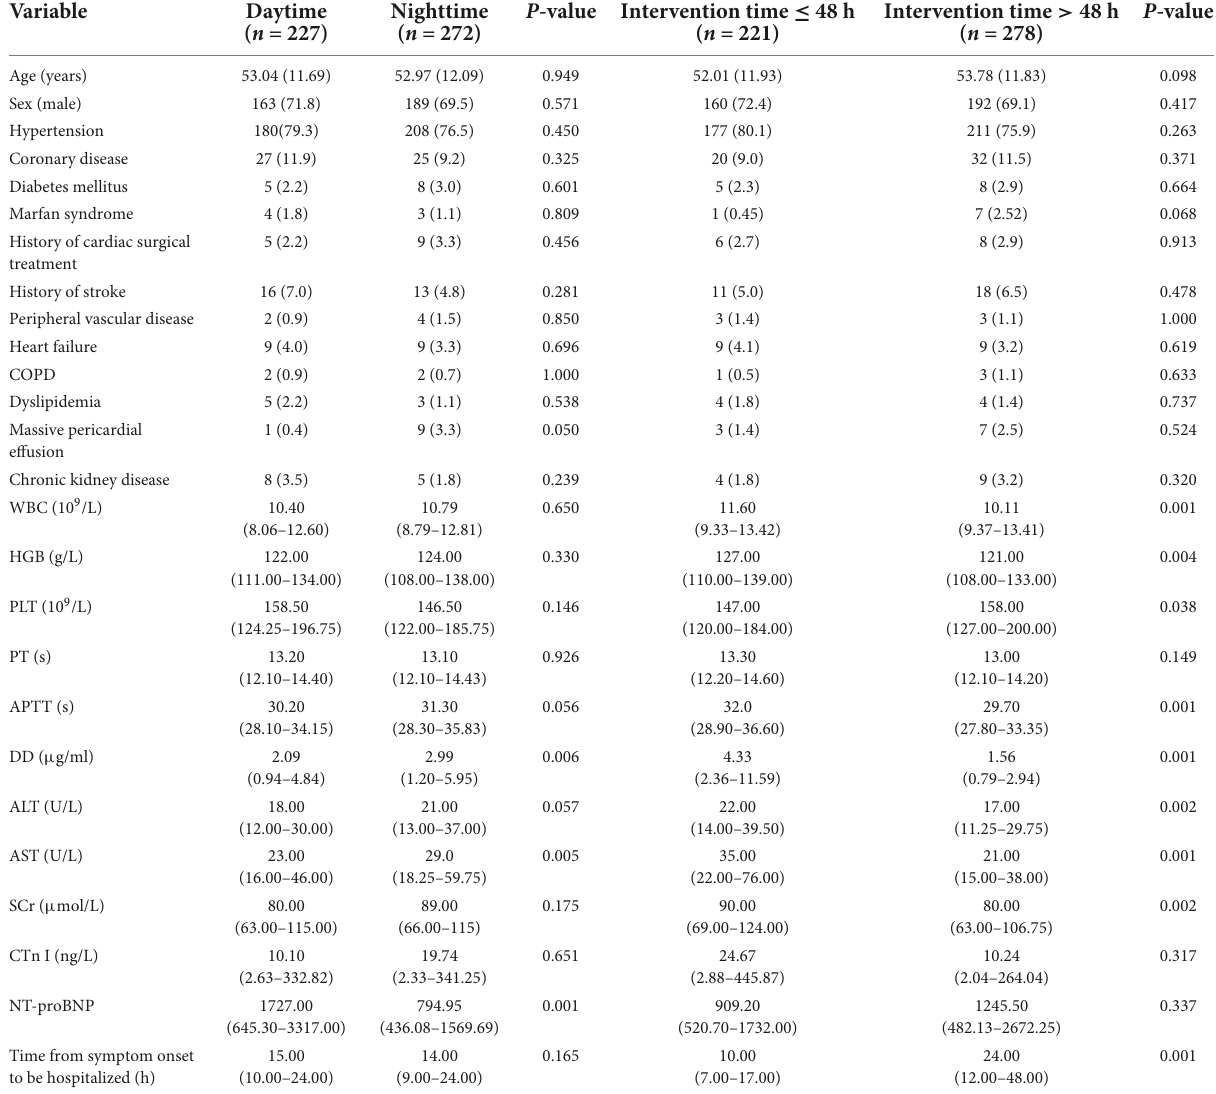
TABLE 3 Preoperative characteristics of daytime and nighttime groups or intervention times ≤ 48 h and > 48